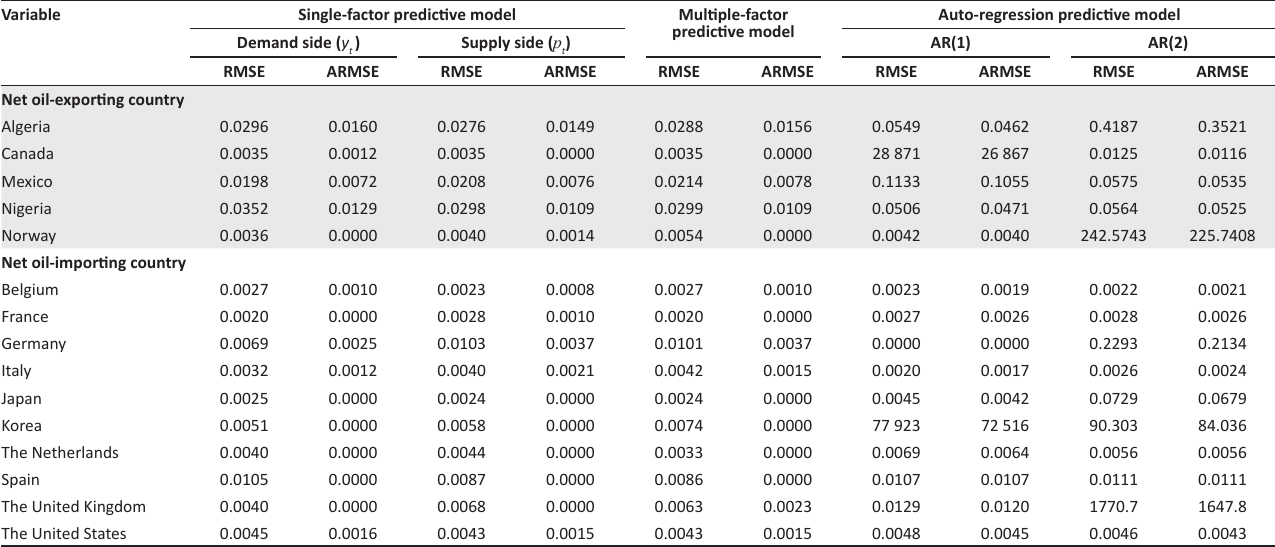
TABLE 6: Out-of-sample forecast performance using the root mean square error and adjusted root mean square error for k = 1 (50 % sample size). Variable